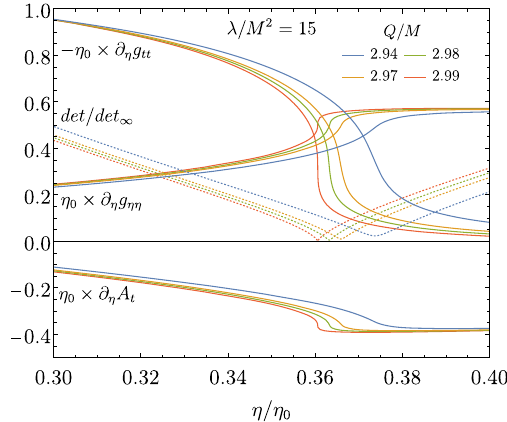
η Fig. 19 Thequantity ( − T t t + T η )/ N isshownversus η/η 0 forcoupling function (i). Here η = 0 refers to a throat n t n t and inserting these into the NEC, e.g., T μν n μ n ν = T t t